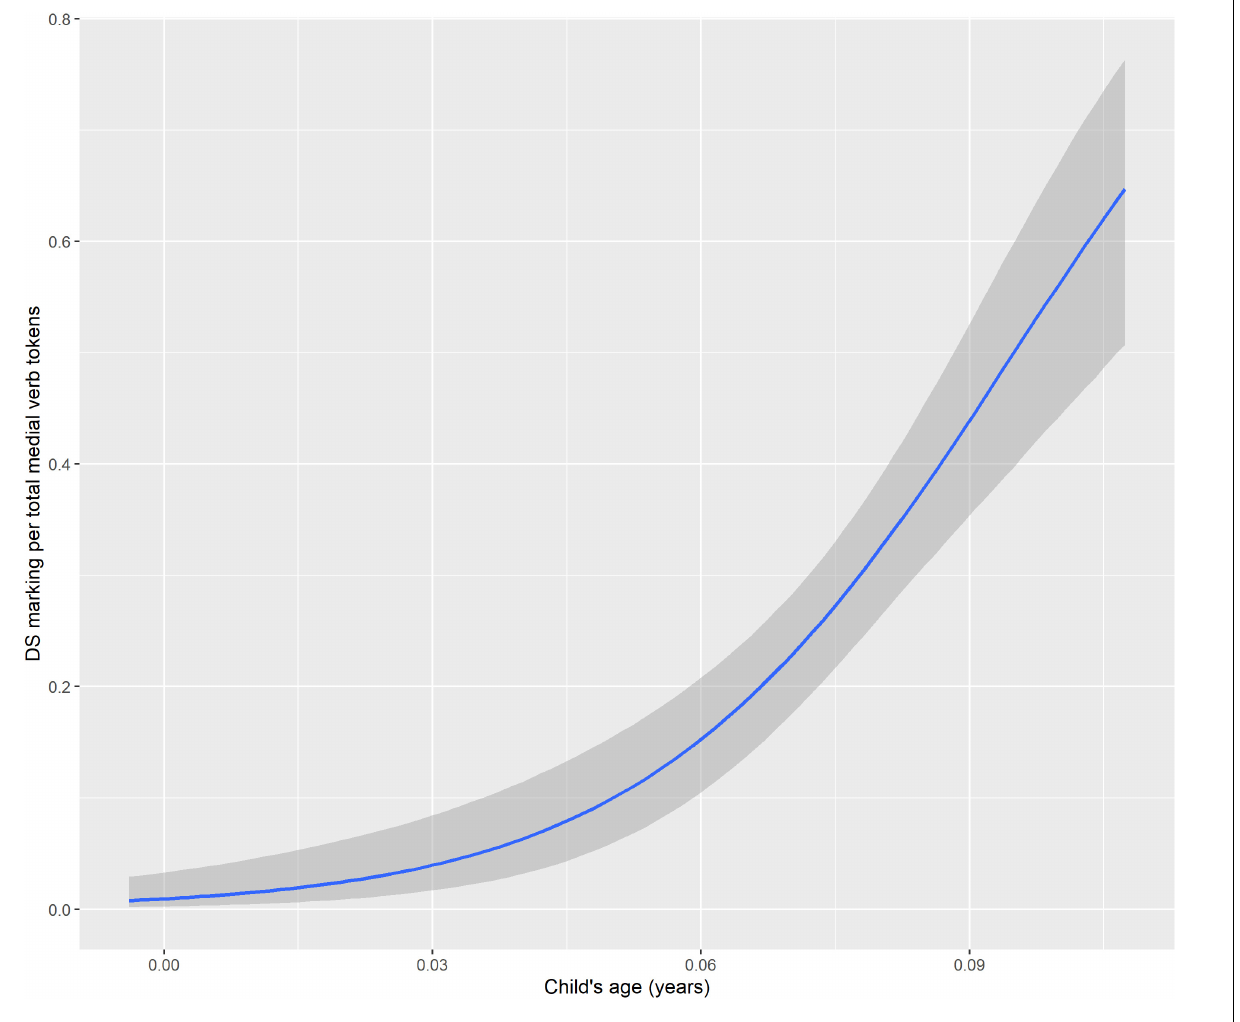
FIGURE 10 | Conditional effects of age on DS